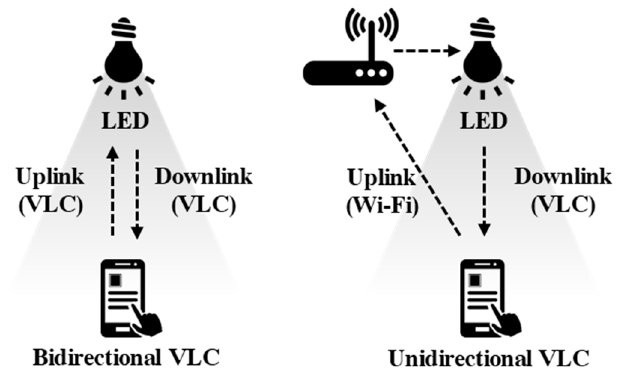
Figure 2. Comparison of bidirectional VLC and unidirectional VLC.